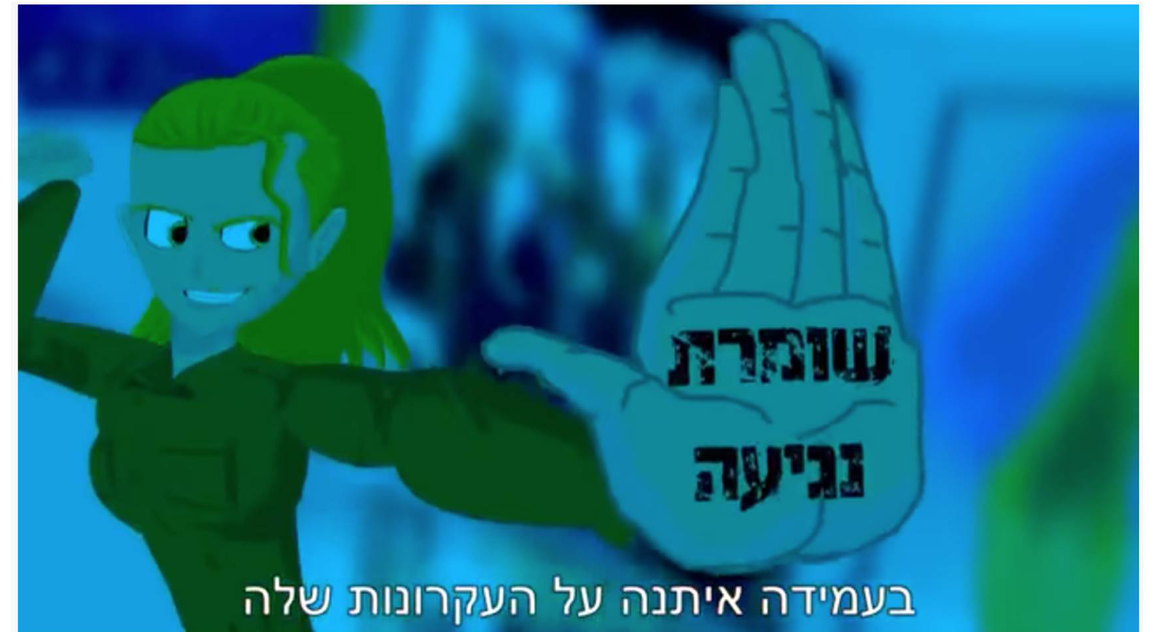
Figure 1. ‘Alone in battle—the story of a religious [female] soldier’ (January 2017). [Hebrew wording on the soldier’s hand: “ shomeret negiah ”, literally meaning “observant of touch,” refers to observant Jewish women who refrain from physical contact with men who are not their immediate family members.]. (Supplementary material).